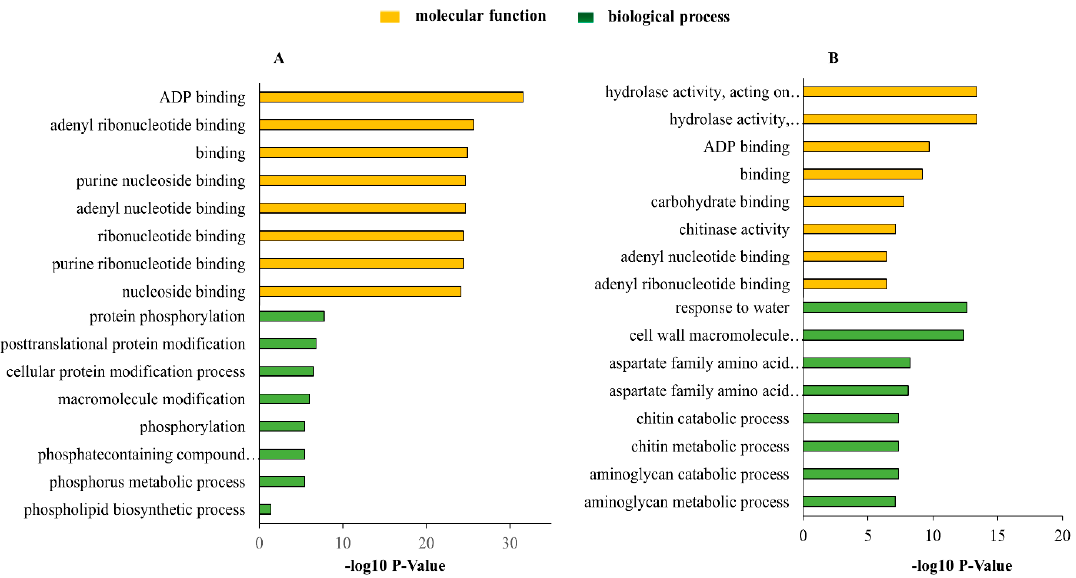
Figure 6. Functional annotation analysis of differentially expressed genes (FDR < 0.05) at ( A ) 10 and ( B ) 12 days after infection with STB.